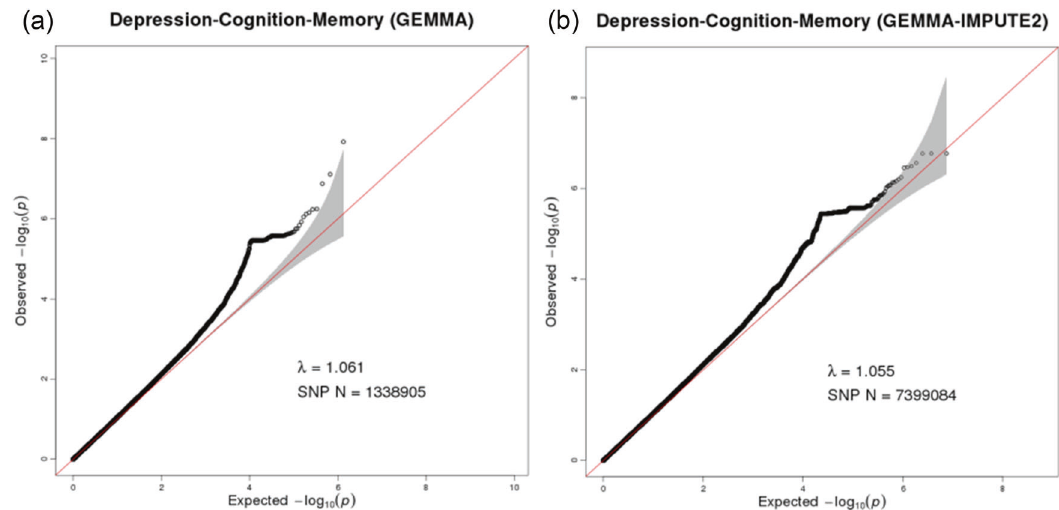
Fig. 2 Quantile-quantile plot for multivariate genome-wide association study of depression-cognition-memory. a The quantile-quantile plot based on data before imputation. b The quantile-quantile plot based on data after imputation. The horizontal axis represents the expected − log 10 ( P ), while the vertical axis represents the observed − log 10 ( P ). The red line represents the expectation of the null hypothesis of no association, and the gray shaded area represents 95% con fi dence intervals of the null hypothesis. The black dots represent the observed data, and λ indicates genomic in fl ation.